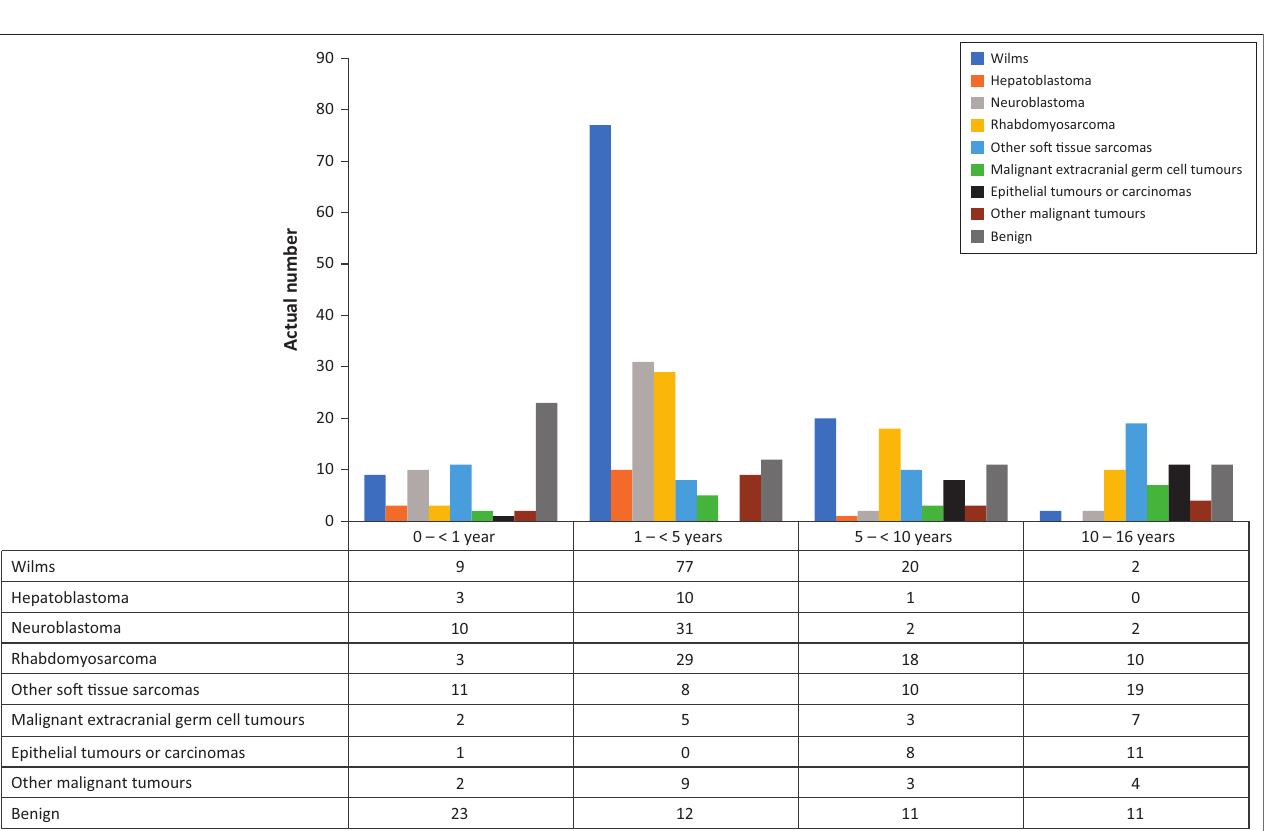
FIGURE 2: Age distribution of the